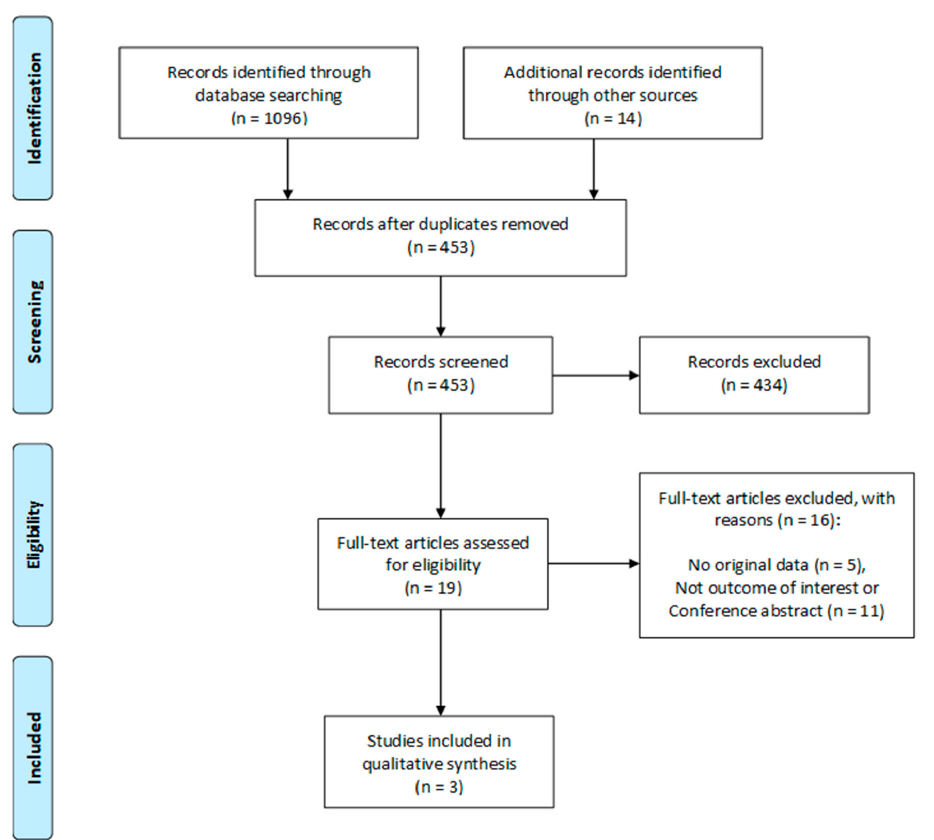
Figure 1. Preferred Reporting Items for Systematic Reviews and Meta-Analyses (PRISMA) flow 148 Figure1. diagram. 149